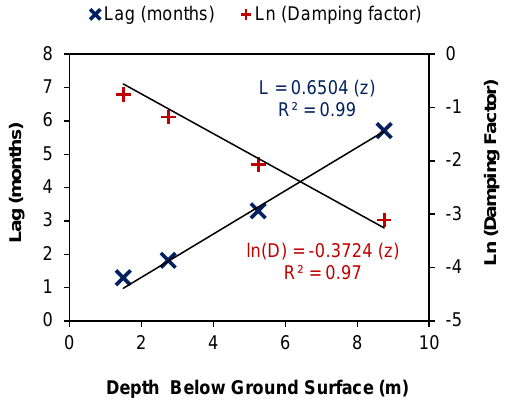
Fig. 10. The lag factor ( L ) and natural logarithm of the damping factor ( D ) plotted vs. depth ( z ). The L and D parameters were ob- tained from fitting Eq. (2) to measured groundwater